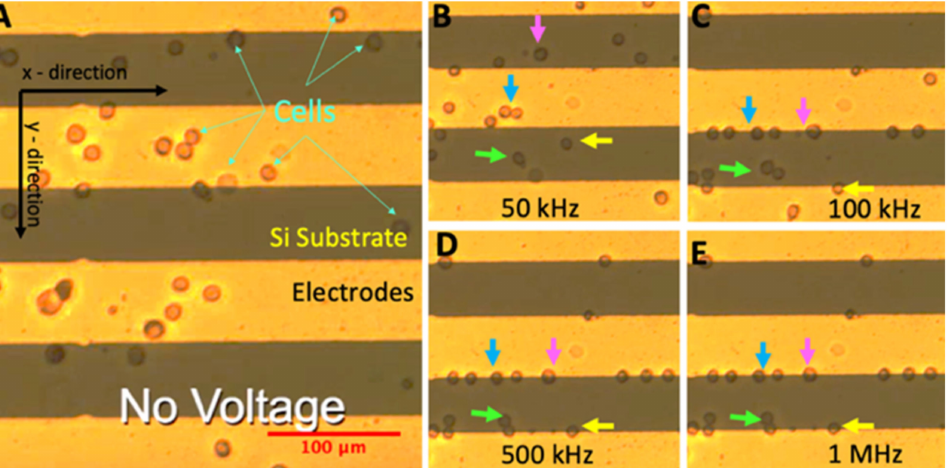
Figure 3. U87 glioma cells in the electrode array. Movement of glioma cells when the electric field was ( A ) off and when 3 V pp at ( B ) 50 kHz, ( C ) 100 kHz, ( D ) 500 kHz, and ( E ) 1 MHz frequencies were applied. Arrows show the movement of glioma cells. The scale bar is 100 µ